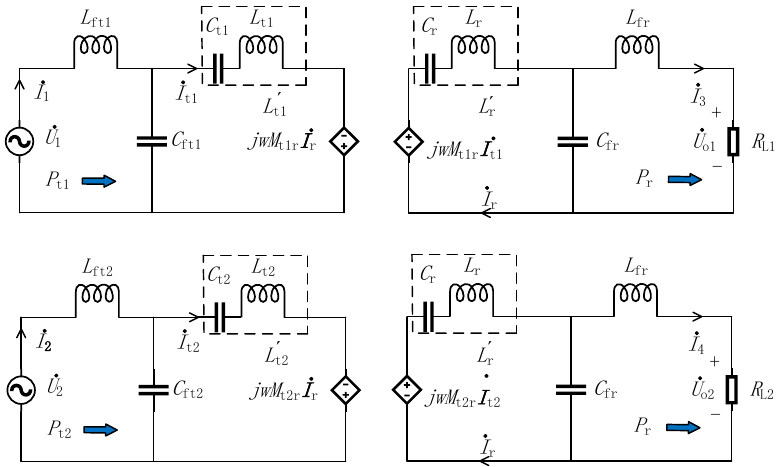
Figure 10. Equivalent circuit diagram of a dual transmitter